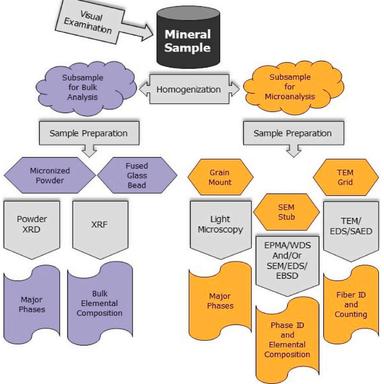
Schematic of general workflow for preparation and analysis of a mineral sample.